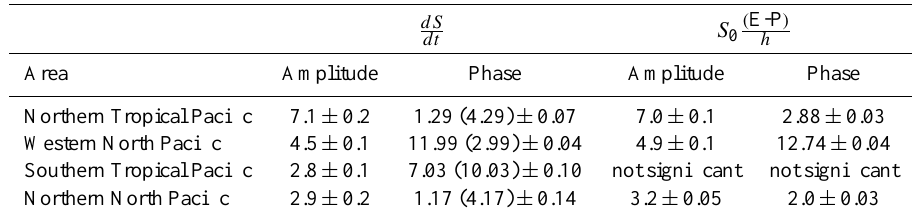
Table 1. Amplitudes and phases of seasonal constituents shown in the first line in areas shown in Fig. 11. Amplitudes are in units of 10 − 8 pss/s. Phases are in months, 1=1 January, 2=1 February, etc., and indicate the month of maximum value. Phase values in parentheses are dates of maximum salinity in each area and correspond approximately with the peaks of the curves in Fig. 11. Error bounds represent 95% confidence intervals found through a propagation of errors